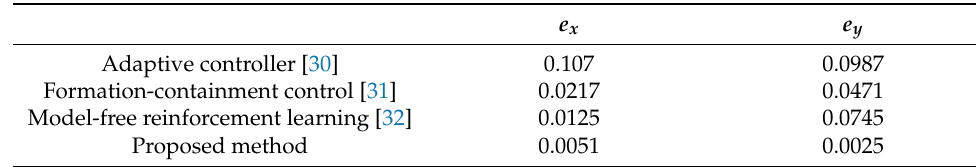
Table 3. MSE comparison.